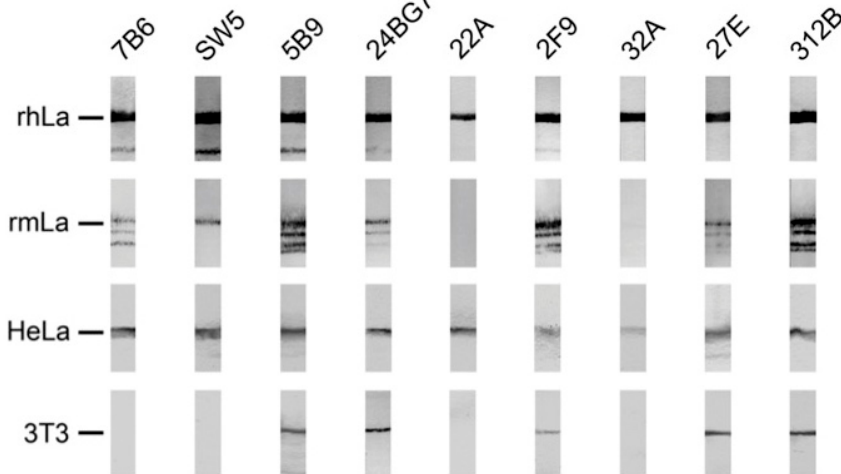
Figure 6. Reactivity of mabs to human and mouse La protein analyzed by SDS-PAGE and im- munoblotting. Human (rhLa) or mouse (rmLa) La protein recombinantly expressed in E. coli or total extracts from eukaryotic human (HeLa) or mouse (3T3) cells were analyzed by SDS-PAGE and immunoblotting.